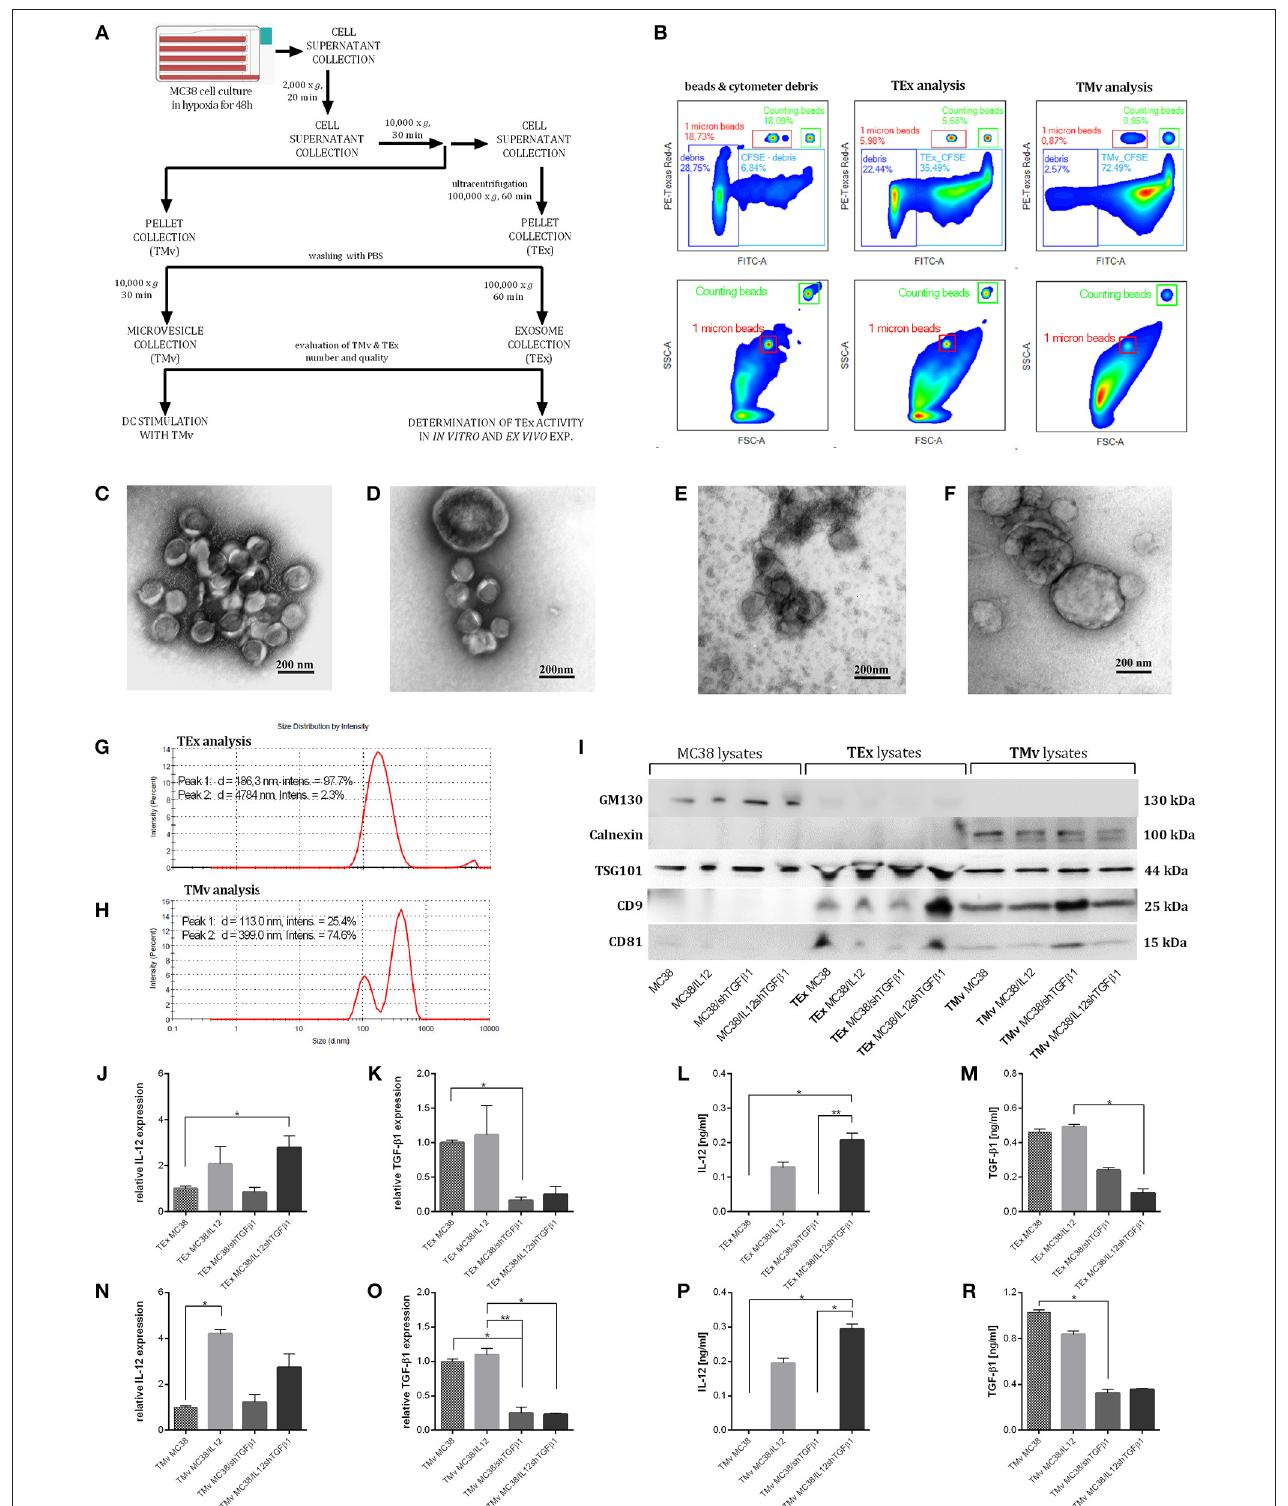
FIGURE 2 | The method of isolation and characterization of TEx and TMv released by wild-type or genetically modified MC38. (A) Scheme of TEx and TMv isolation. (B) Representative density plots showing the method of evaluation and counting of CFSE stained TEx and TMv using the LSR Fortessa flow cytometer. The data are